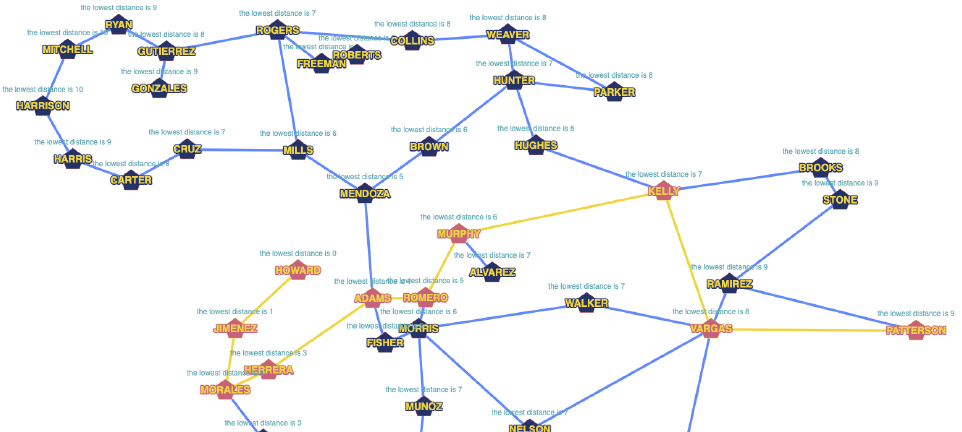
Figure 5. Detail of the result of the optimal path between nodes Howard and Patterson after eliminat- ing segment that linked node Howard and node Mills by applying Dijkstra’s